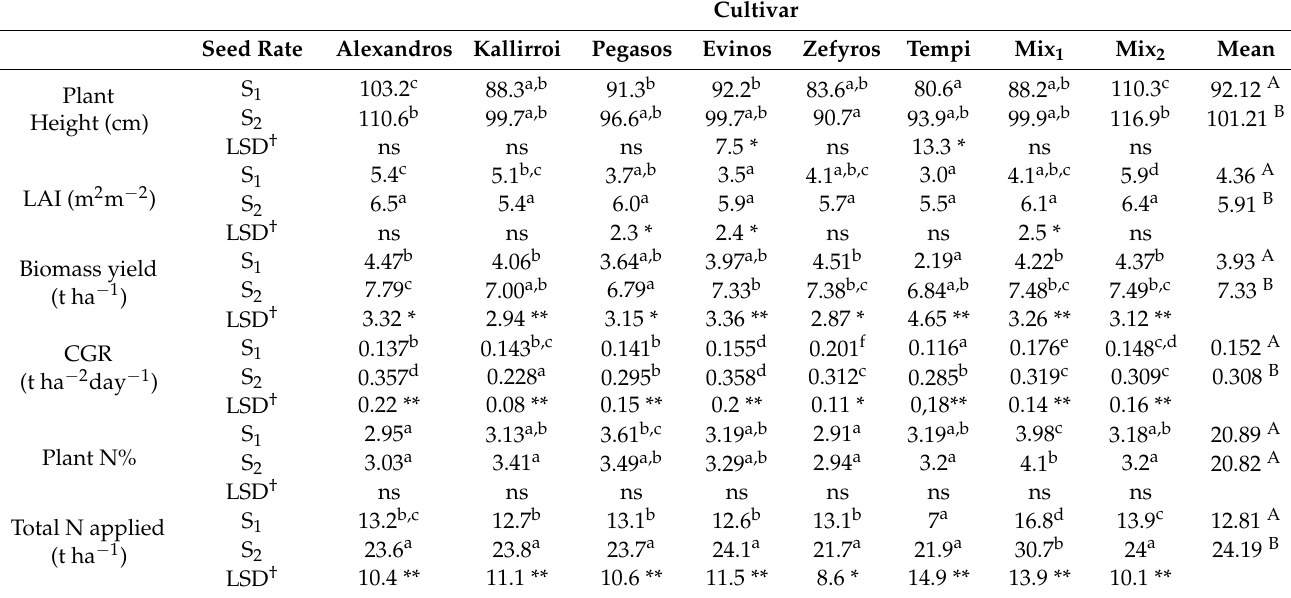
Table 3. Agronomic traits at two seed rates (S 1 , S 2 ) of each cultivar and cultivar mixture. Plant height (cm), leaf area index (LAI; m 2 m − 2 ), biomass yield (t ha − 1 ), crop growth rate (CGR; t ha − 2 day − 1 ), plant nitrogen concentration (N%) and total N applied. Different letters indicate significant differences between/among means of cultivars within the same seed rate at p < 0.05, according to Tukey’s method, and LSD† indicate significant differences between seed rates within the same